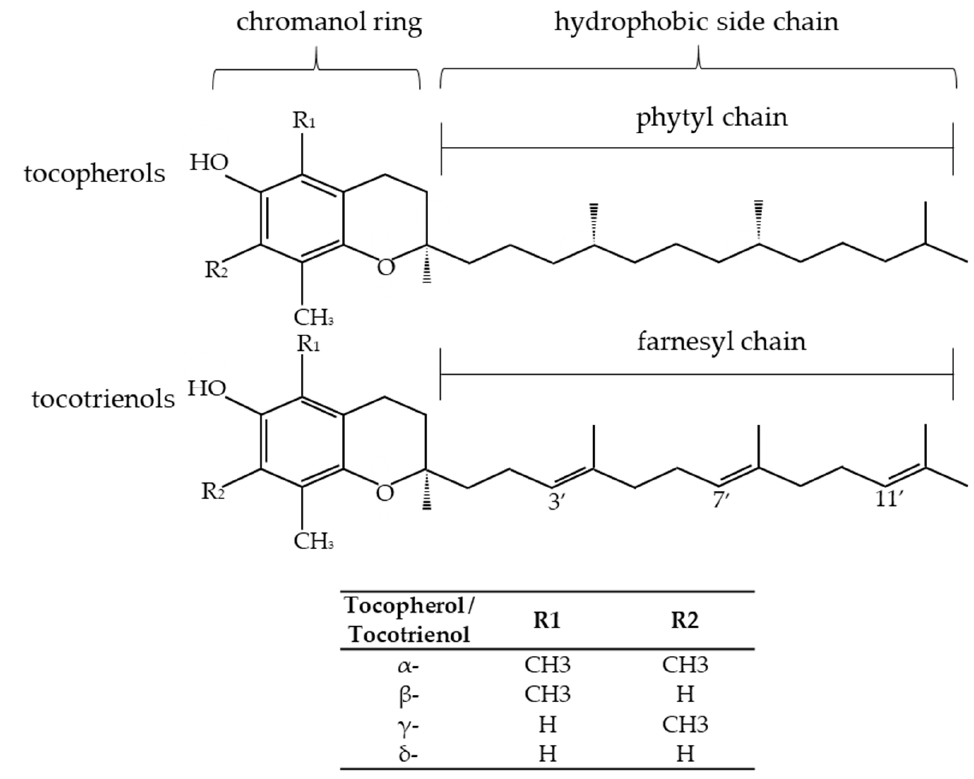
Figure 1. The structure of tocopherols, tocotrienols, and differences in the structure of their isoforms [17,18].